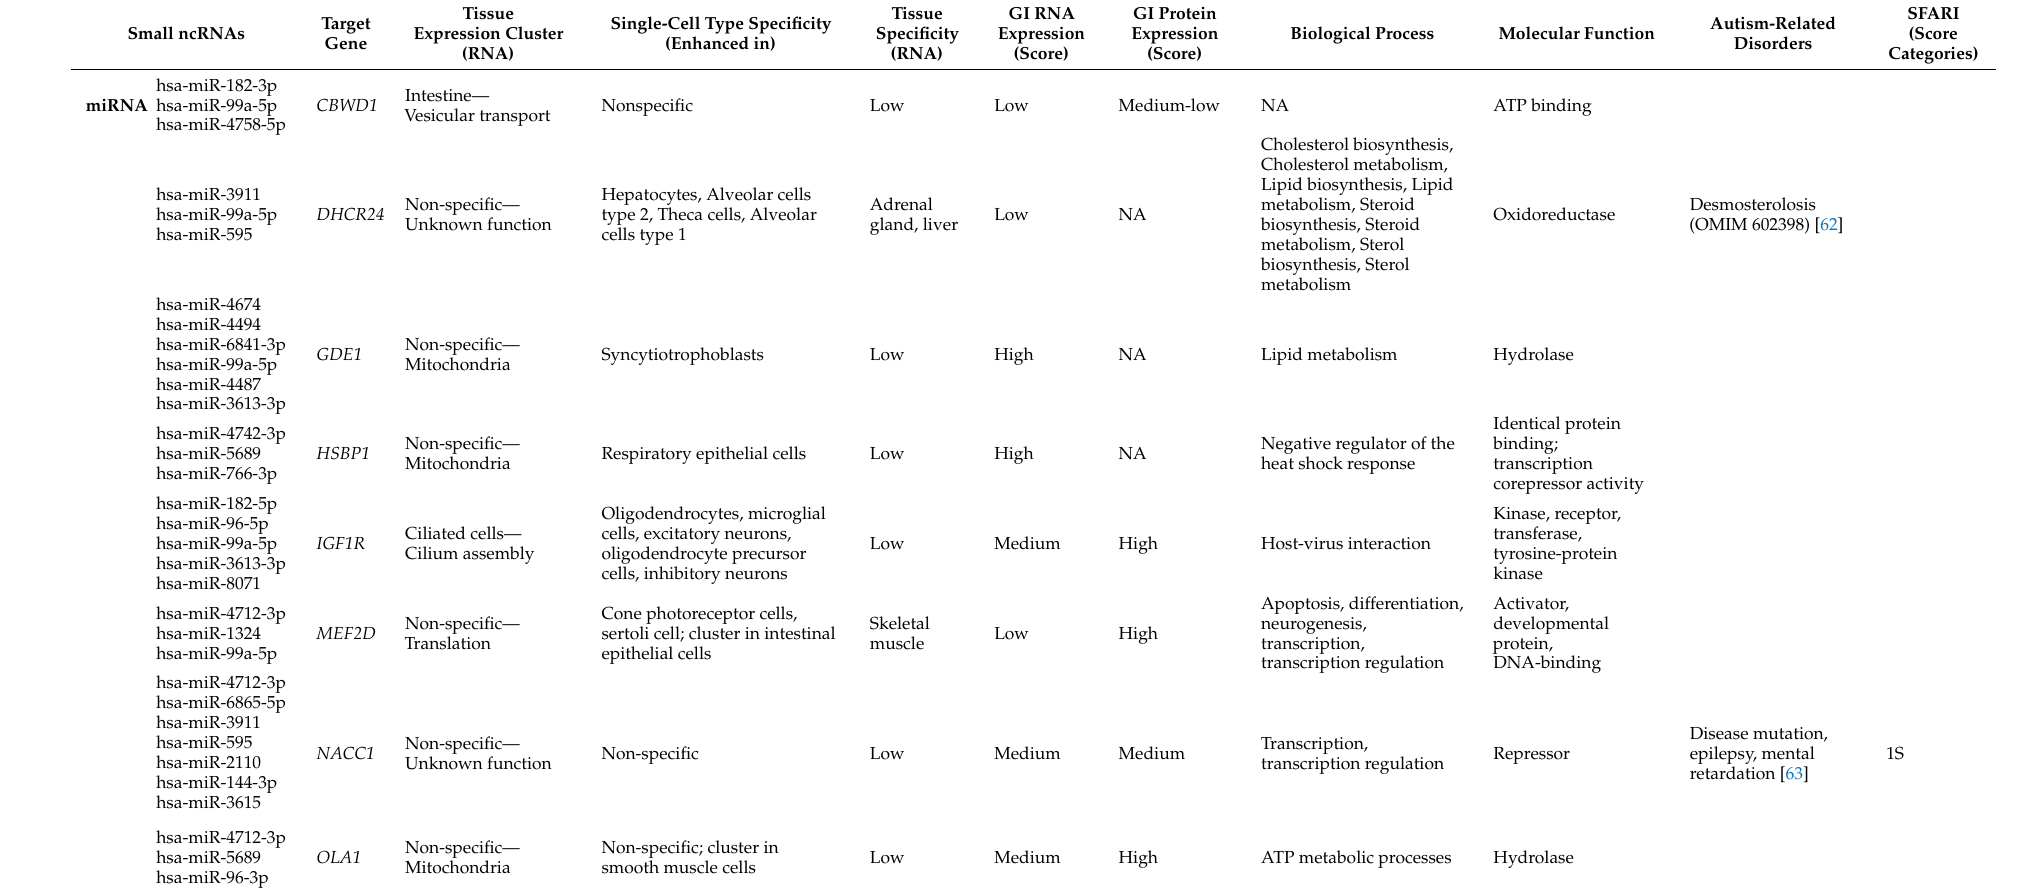
Table 1. List of miRNAs, piRNAs and miRNA + piRNAs common targets. “Single-cell type specificity” was obtained by single-cell transcriptomics; “Tissue specificity (RNA)” and “GI RNA expression” were obtained by RNA-seq; “GI protein expression” was obtained by immunocytochemistry investigations. All these data are from ProteinAtlas (https://www.proteinatlas.org, accessed on 2 December 2021). Biological process and Molecular function data are from UniProt (https://www.uniprot.org, accessed on 2 December 2021). SFARI score categories are reported in the following website